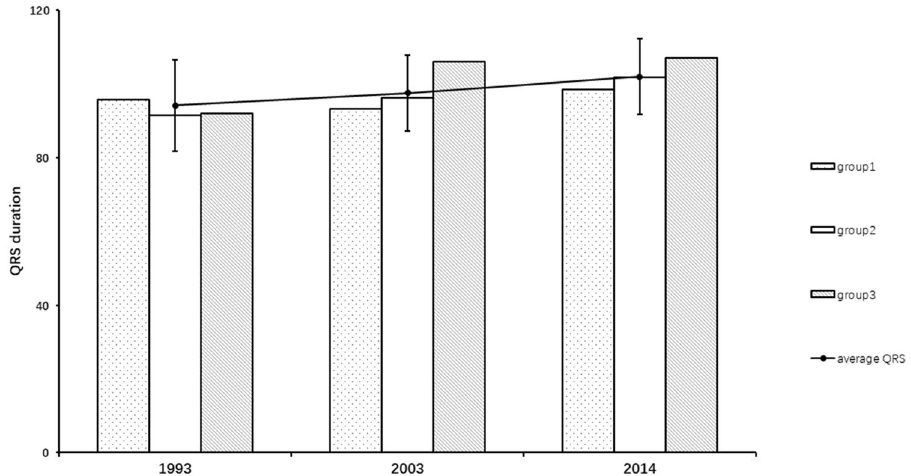
Figure 1. Baseline, final and ΔQRS width in participants reporting in different QRS change groups (group 1: ΔQRS < 4 ms, group 2: 4 ms ≤ ΔQRS < 8 ms, group 3: ΔQRS ≥ 8 ms).